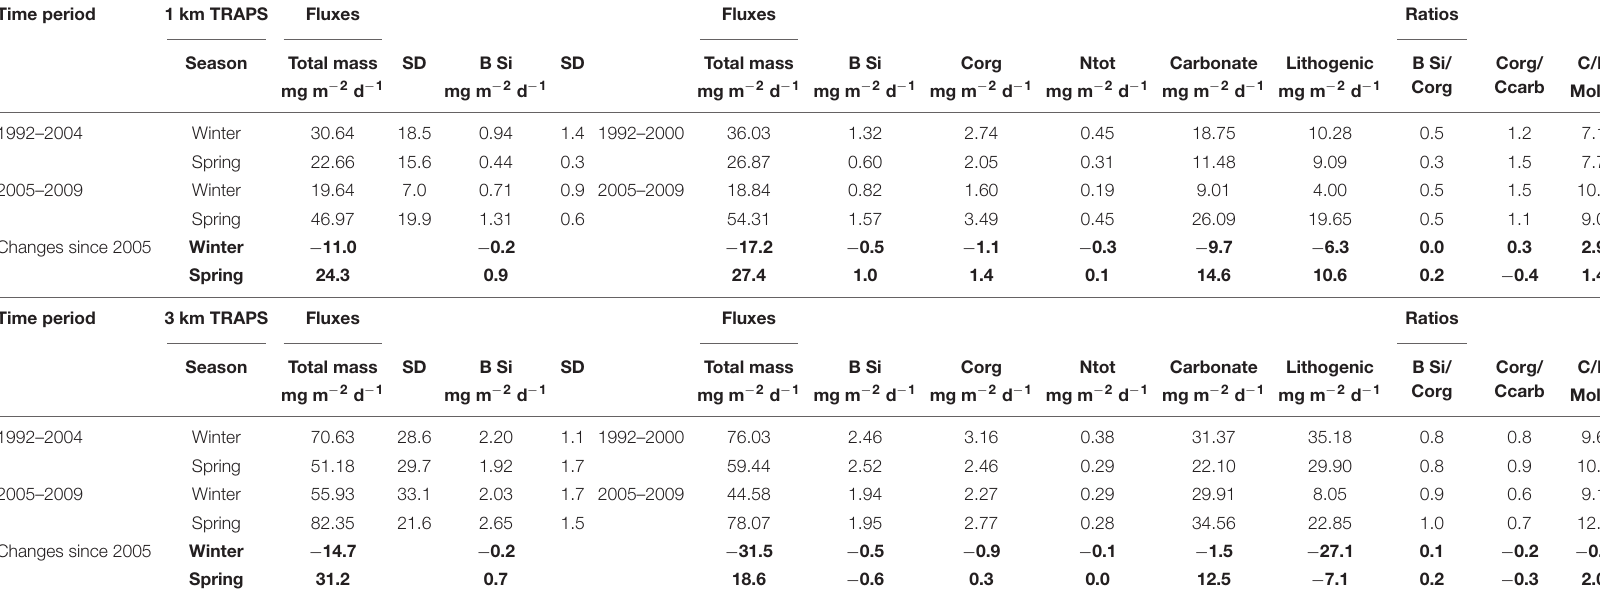
TABLE 3 | Mean seasonal winter and spring fluxes (in mg m − 2 d − 1 ) and ratios and their seasonal changes since 2005 (bold numbers) measured at 1 km and 3 km depths in the Canary Basin. Time period 1 km